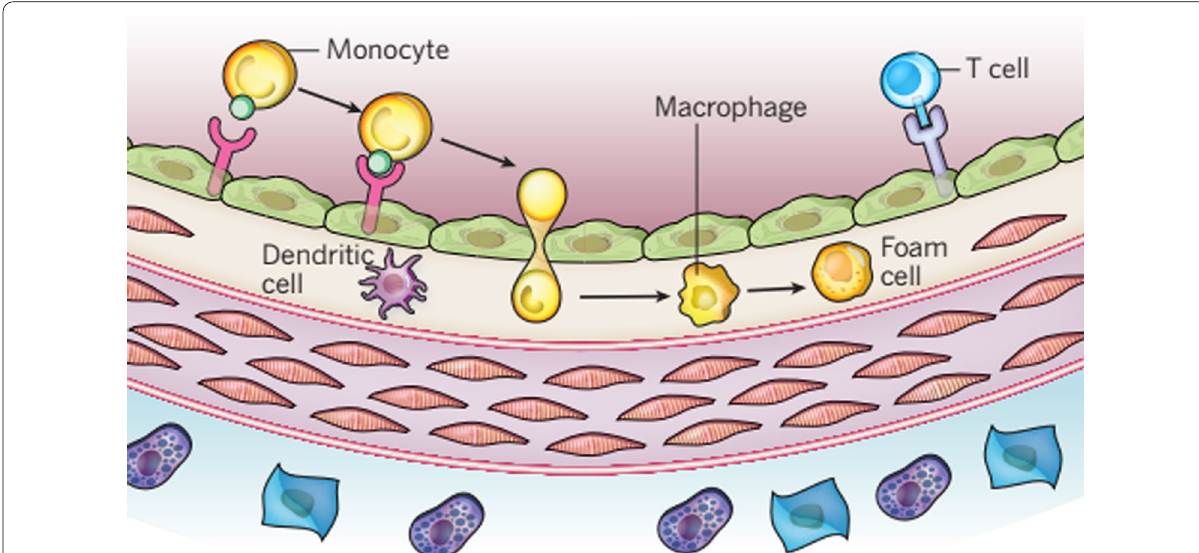
Fig. 2 The initial steps of atherosclerosis. It include adhesion of blood leukocytes to the activated endothelial monolayer, directed migration of the bound leukocytes into the intima, maturation of monocytes (the most numerous of the leukocytes recruited) into macrophages, and their uptake of lipid, yielding foam